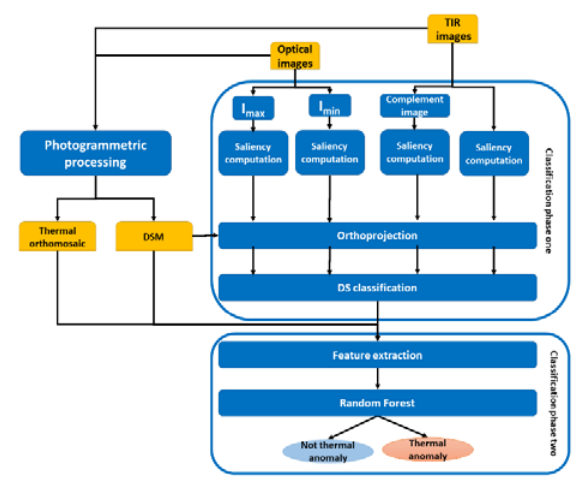
Figure 1: Method overview (see text for